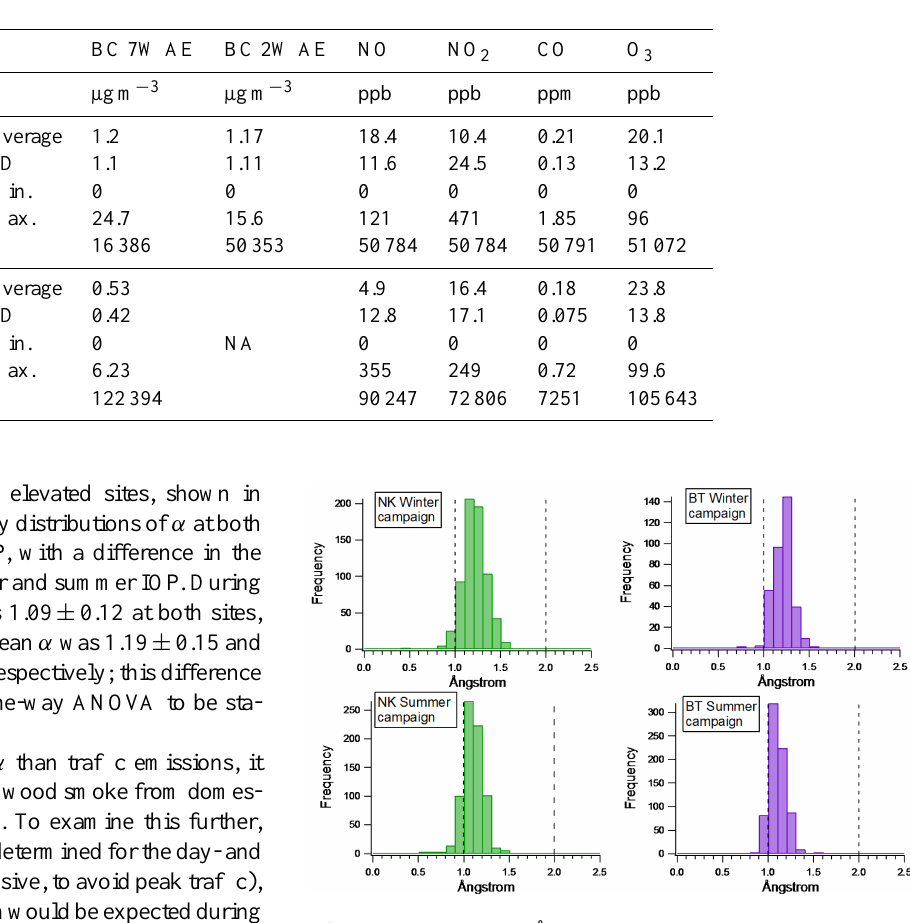
Table 7. Summary statistics of the long-term measurements at NK and the BT tower. Note the values given for 7W AE at NK are the combined data from summer and winter campaigns. Note NA means not available.